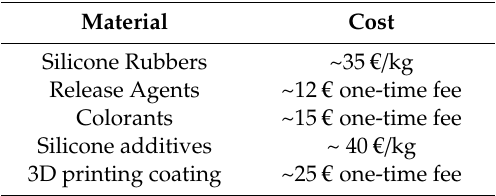
Table 3. The material costs for the production of soft